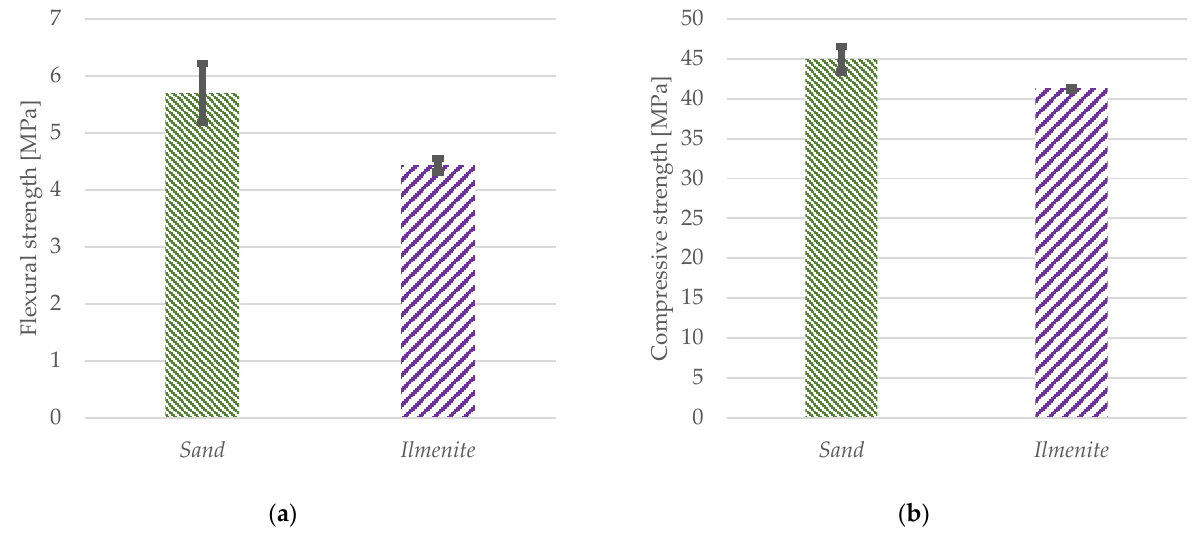
Figure 4. Strength: ( a ) flexural and ( b ) compressive.